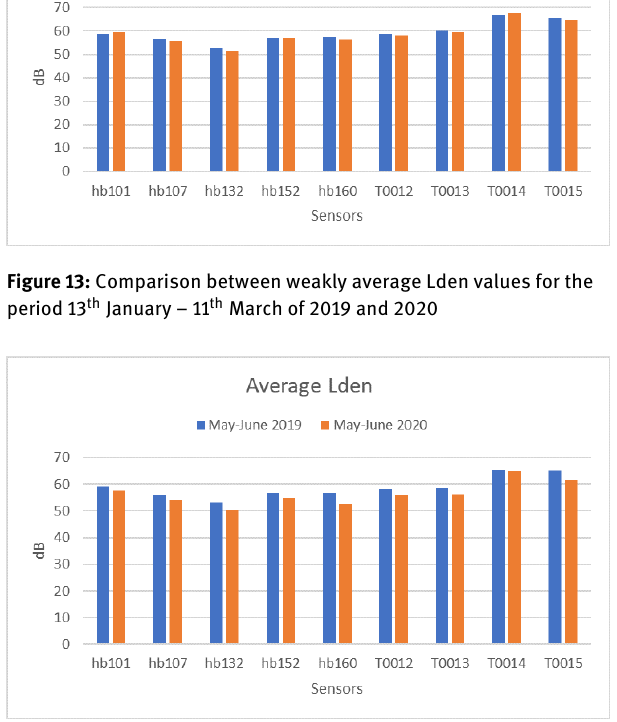
Figure 14: Comparison between weakly average Lden values for